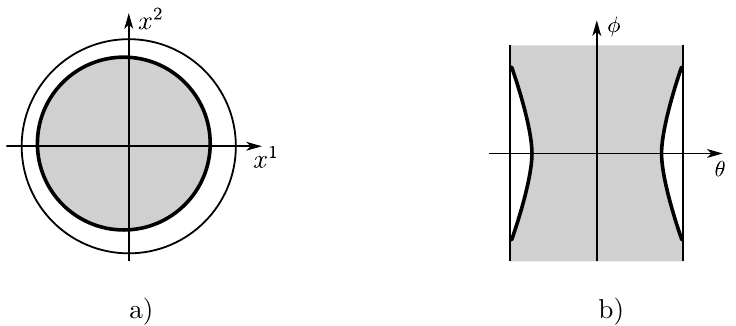
Figure 1 . a) The regularization of the JT action on H 2 reveals a free particle with spin. b) We analytically continue the action to g AdS 2 , making two copies of the particle, in order to de(cid:12)ne a two-sided black hole system.